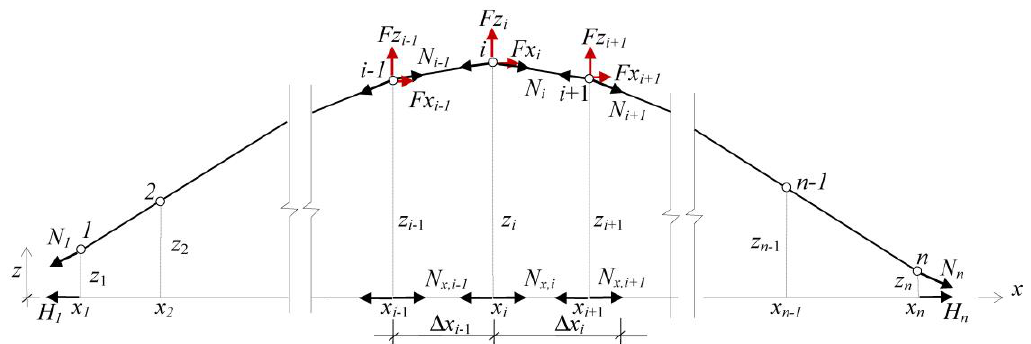
Figure 6. Use of FDM for arch form-finding. Vertical projection.